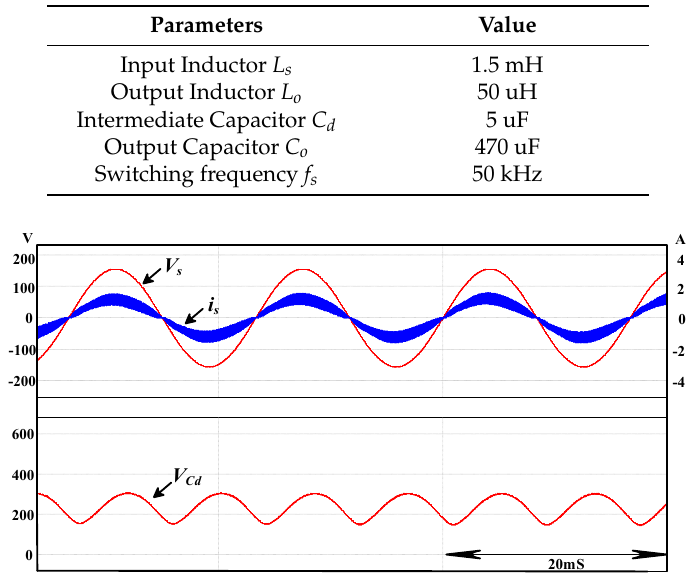
Figure 15. Simulation results for (top) the input voltage V s , current i s , and (bottom) corresponding intermediate capacitor voltage.